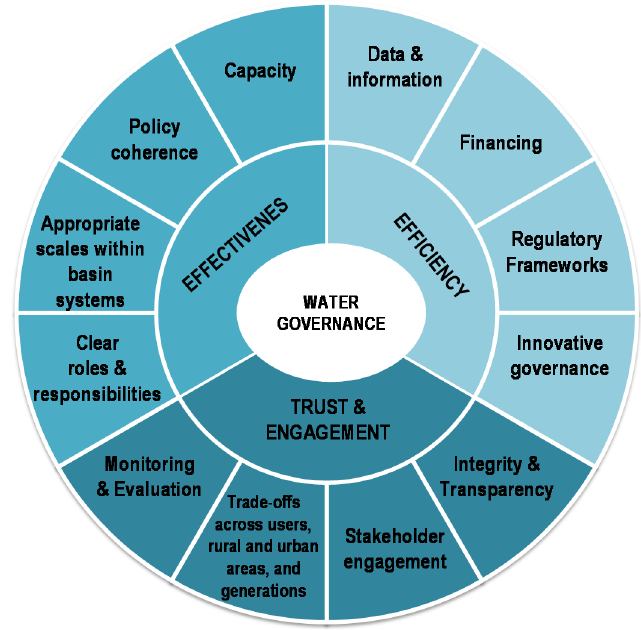
Figure 6. OECD Principles on Water Governance [8].